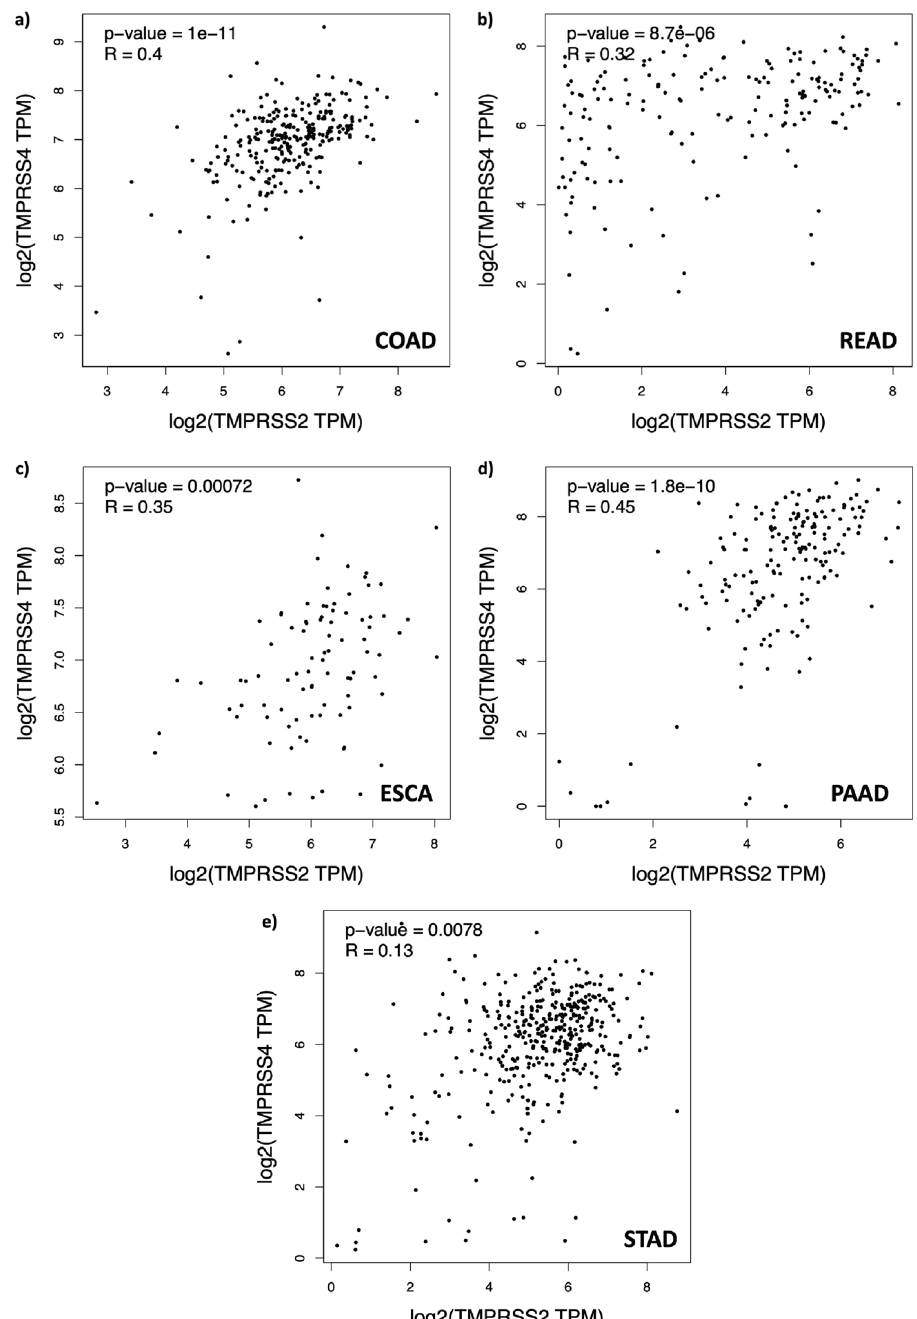
Figure 2. Correlation analysis results of TMPRSS2 and TMPRSS4 genes in gastrointestinal cancer tissues. Relationship of TMPRSS2 and TMPRSS4 with respect to their expression values shows moderate positive correlation (R-value > 0.3) in COAD, READ, ESCA and PAAD ( a – d ) and weak positive correlation in STAD samples ( e